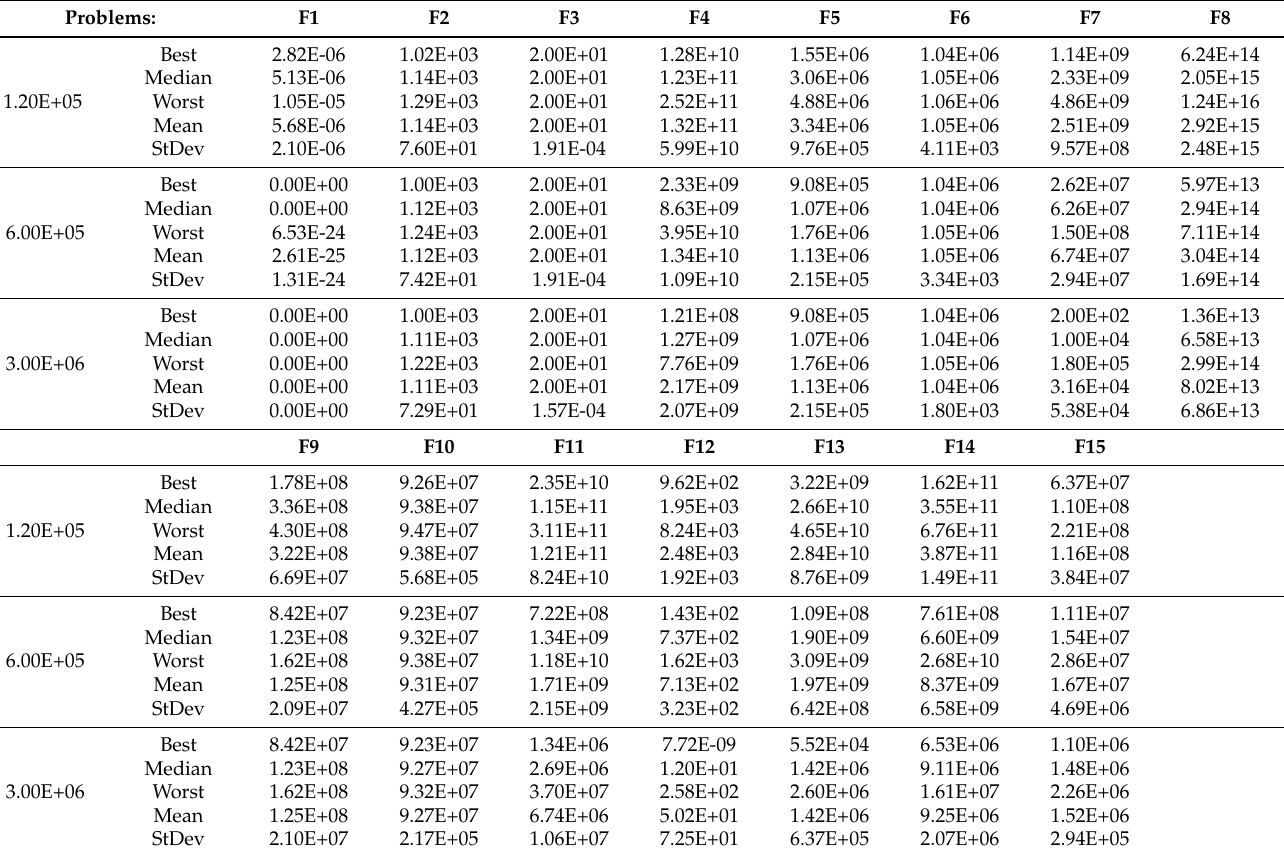
Table 3. The experimental results on the IEEE CEC 2013 LSGO